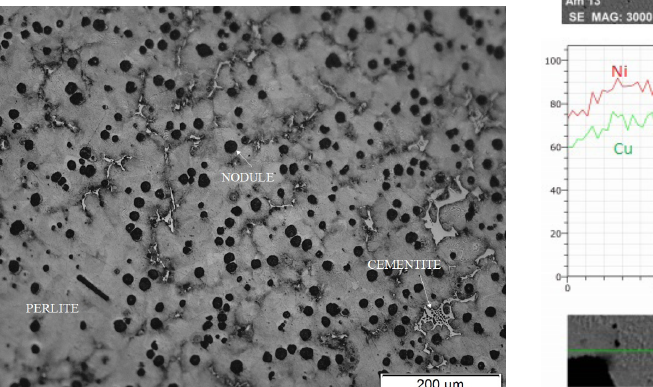
Figure 19. Matrix for Cr/Cu addition.